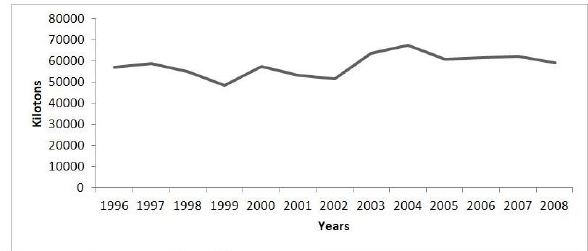
Fig. 7. Total CO 2 emissions embodied in imports to Poland (1996-2008) Source: Authors’ own elaboration